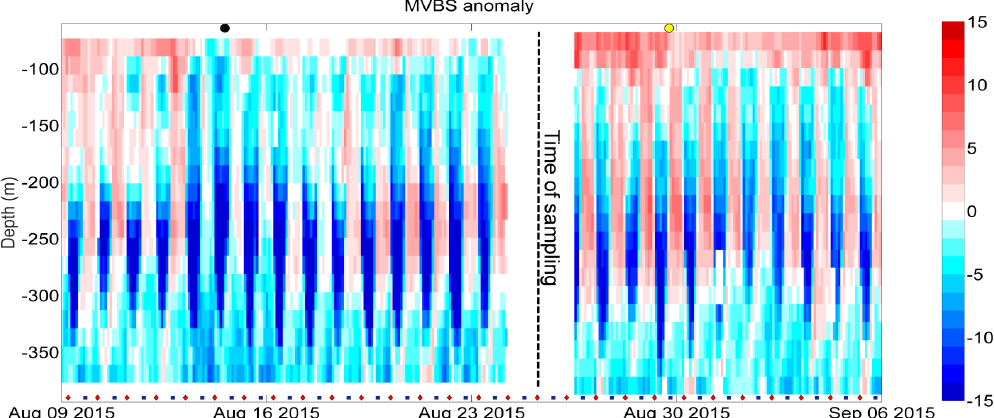
Figure 6. MVBS anomalies (dB re(4 π m) − 1 ) between 9 August and 6 September 2015. The timing of new moon (black dot above the graph), full moon (yellow dot above the graph), sunrise (red diamond below the graph) and sunset (blue square below the graph) is indicated.